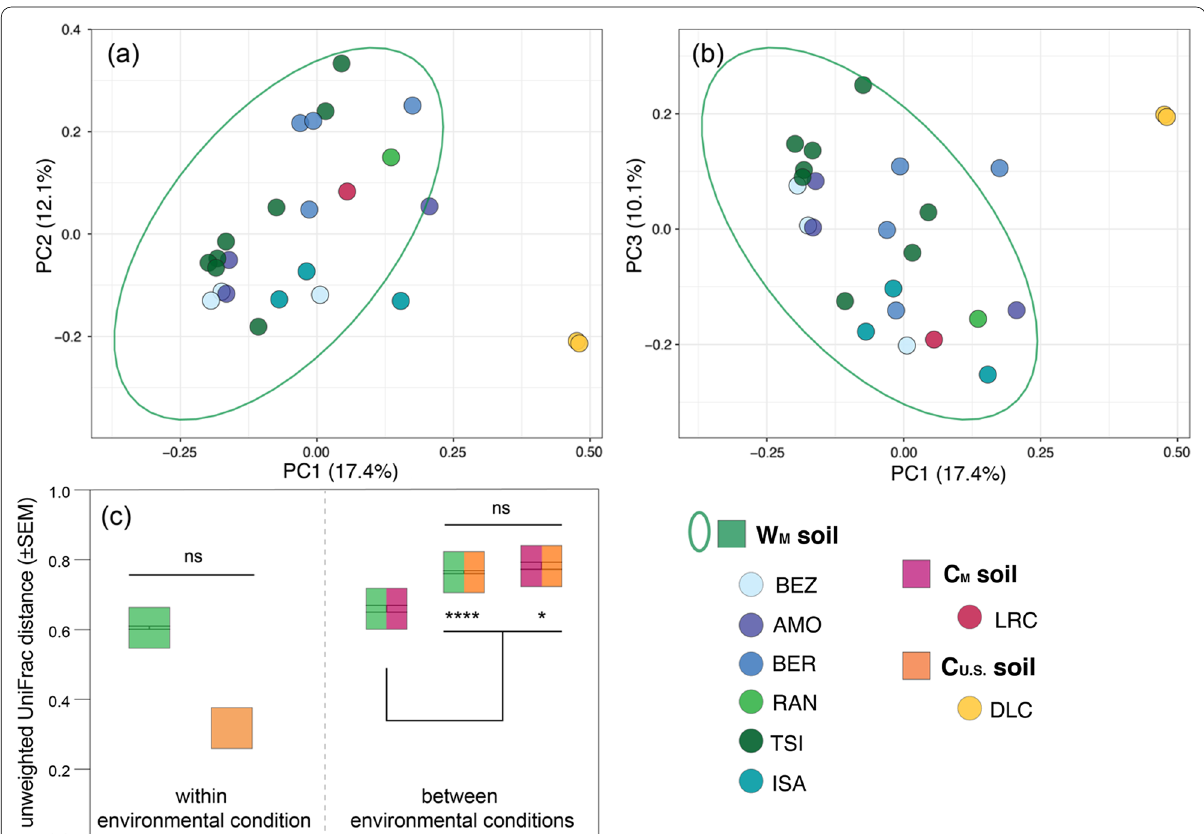
Fig. 7 Beta diversity (unweighted UniFrac distances) of soil microbiota across three environmental conditions—wilderness in Madagascar (W M ; green), captivity in Madagascar (C M ; pink), and captivity in the U.S. (C U.S. ; orange)—that encompass eight setting (see Table 1 for names of abbreviated research settings). a , b Principal coordinate plots, showing axes 1 and 2, or 1 and 3, respectively, of soil microbial communities colored by setting and encircled by normal data ellipses reflecting environmental condition. c Mean beta diversity distance scores within an environmental conditions (single color) and between two environmental conditions (two colors). The center of the box reflects the mean and the error bars represent the standard error of the mean (SEM). Kruskal–Wallis test with Benjamini–Hochberg correction; * p < 0.05, **** p < ±